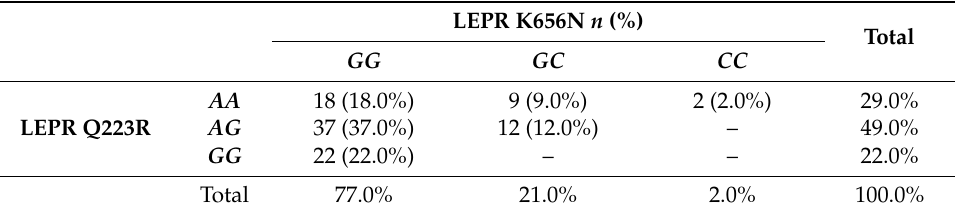
Table 2. Distribution of Q223R and K656N LEPR genotypes in prepubertal obese children.